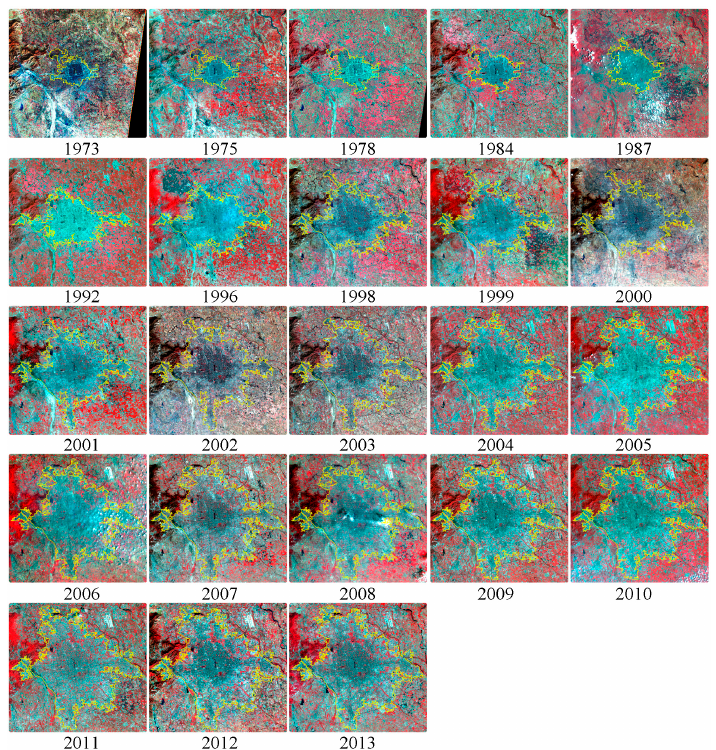
Figure 2. Satellite images and central built-up areas of Beijing, monitored during the period from 1973 to 2013.